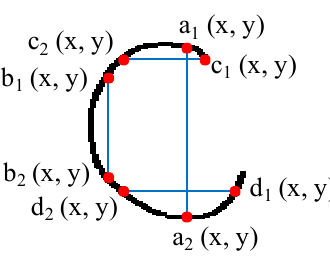
Figure 8. Illustration of closed character determination. 4.